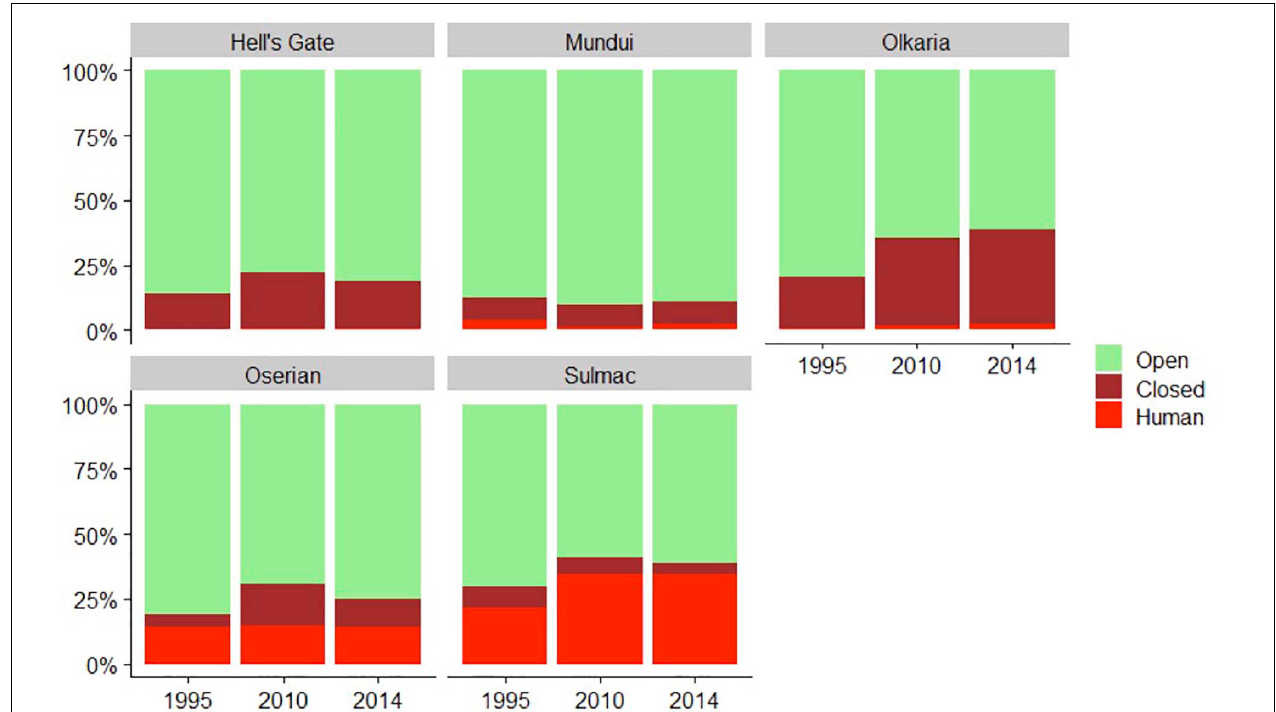
FIGURE 3 | Percent coverage of open, closed, and human development land types in each region of our study, split across 1995, 2010, and 2014.